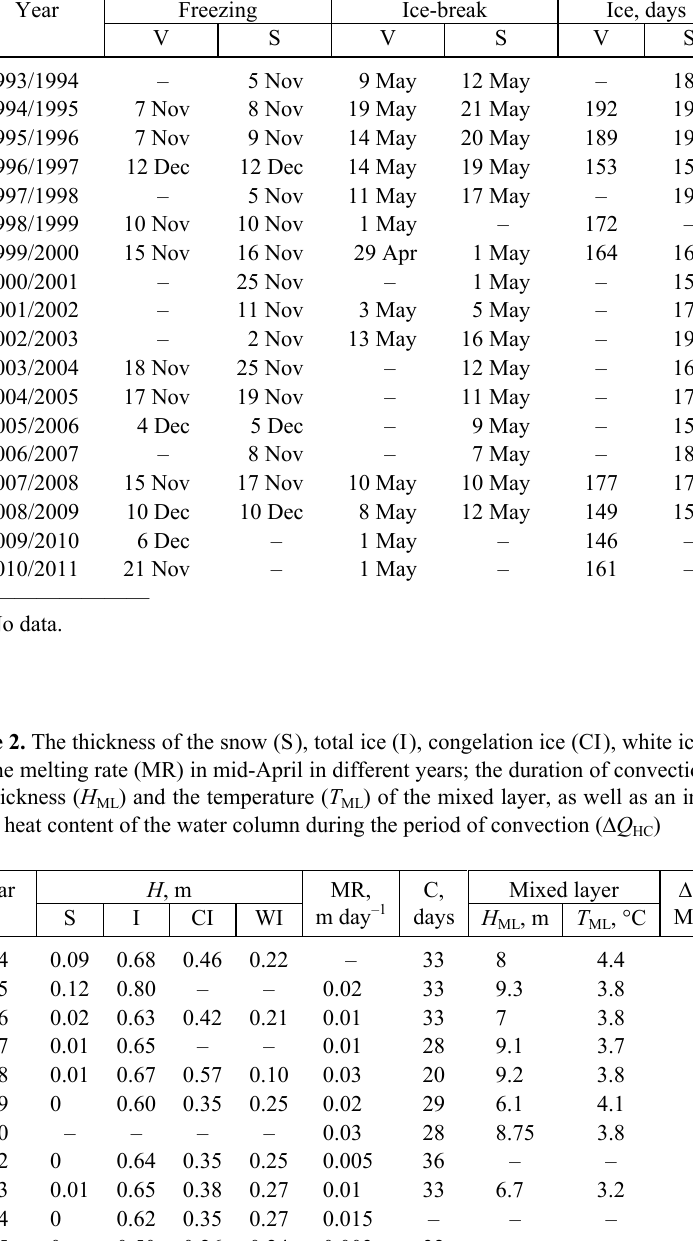
Table 1. The dates of freezing and ice-break of lakes Vendyurskoe (V) and Syamozero (S) and the duration of the ice period in different years Freezing Ice-break